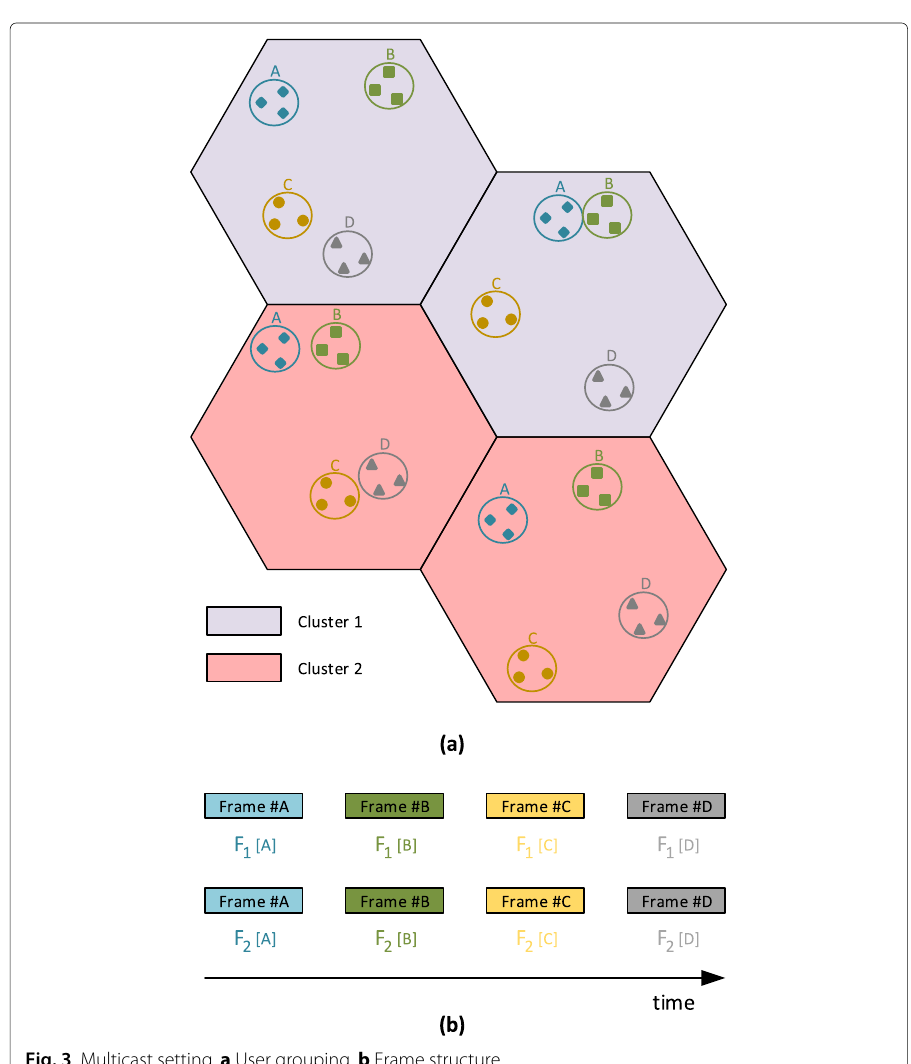
Fig. 3 Multicast setting. a User grouping. b Frame